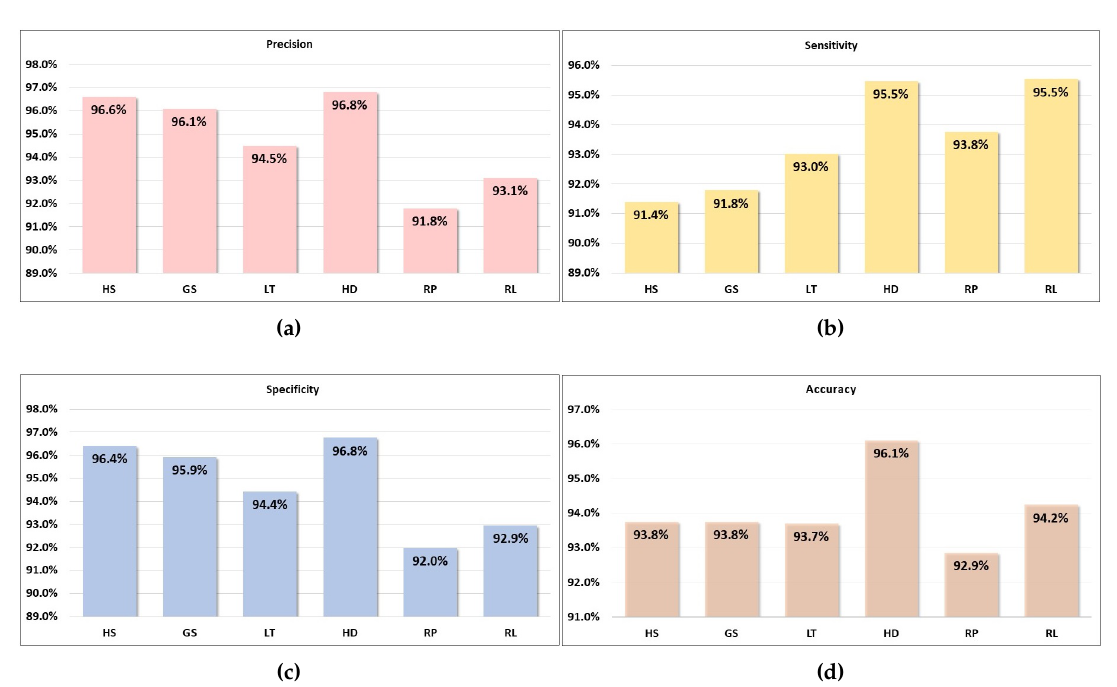
Figure 10. Performance evaluation for classification of six motor events tested in the framework of one-versus-rest based on percentage ( a ) precision, ( b ) sensitivity, ( c ) specificity, and ( d )